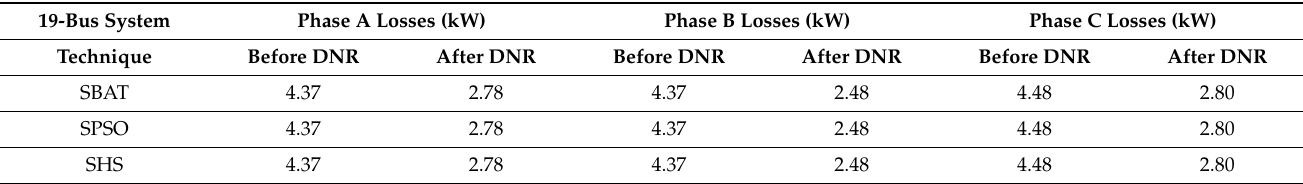
Table 9. Total losses per phase (19-bus system/fixed